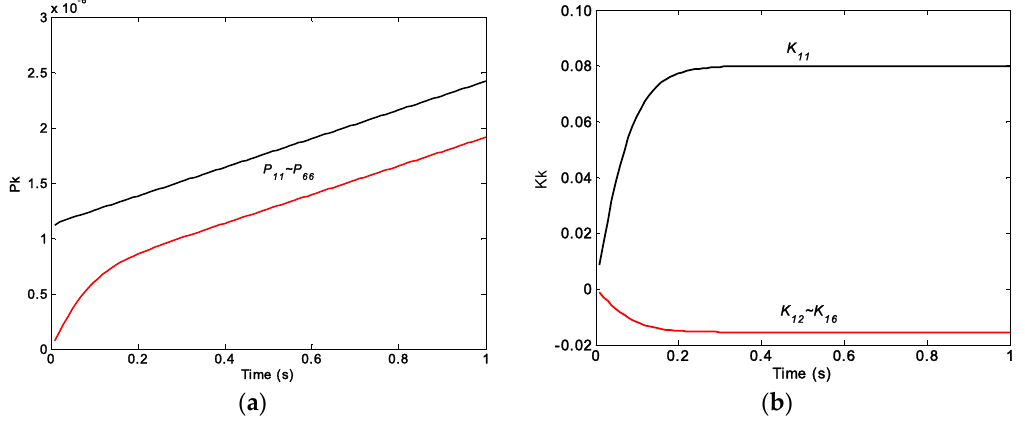
Figure 2. Plot of the KF covariance P ( t ) and gain K ( t ): ( a ) covariance P ( t ); ( b ) gain K ( t ).